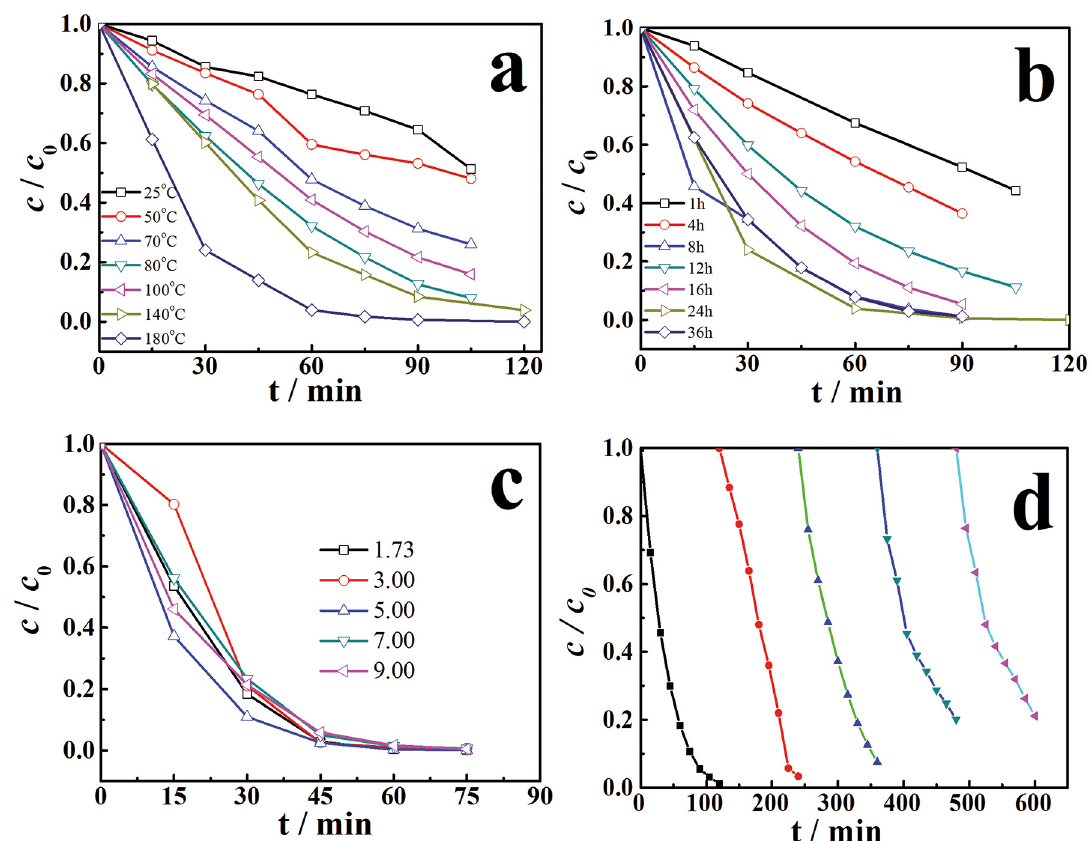
products synthesized under various reaction Figure 6: Photodegradation efficiencies of RhB as a function of irradiation time over CdMoO 4 conditions. (a) temperature series at pH=5 for 24 h, (b) time series at pH=5 and 180 o C, (c) pH series at 180 o C for 24 h, and (d) repeated experiment of RhB photodegradation over CdMoO 4